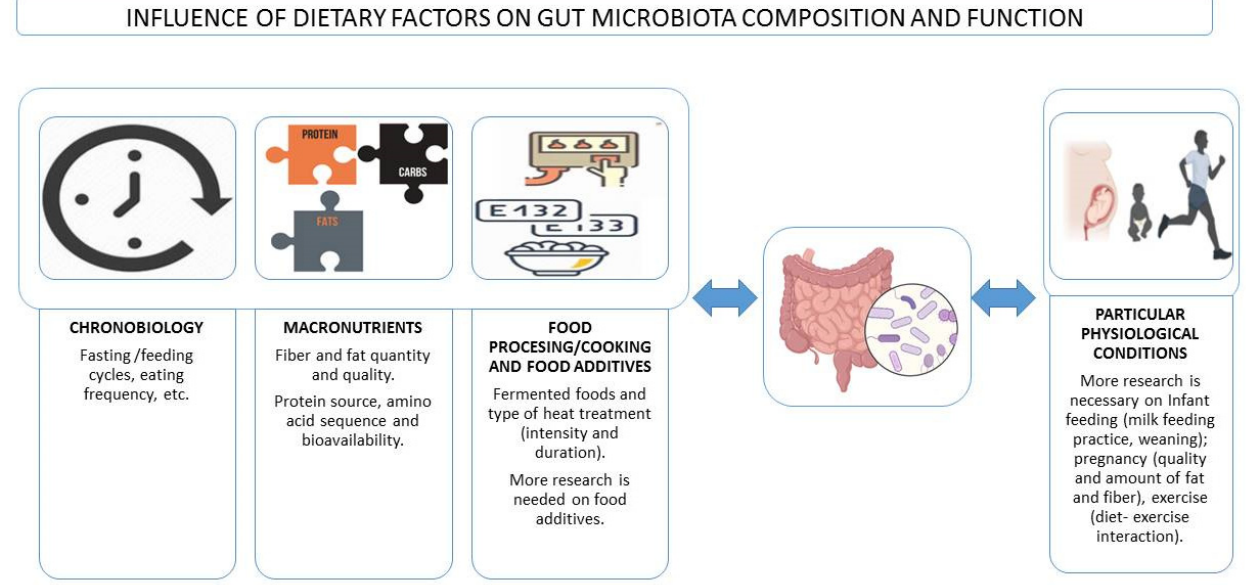
Figure 1. Influence of dietary factors on gut microbiota composition and function and interactions with particular physiological conditions . with particular physiological